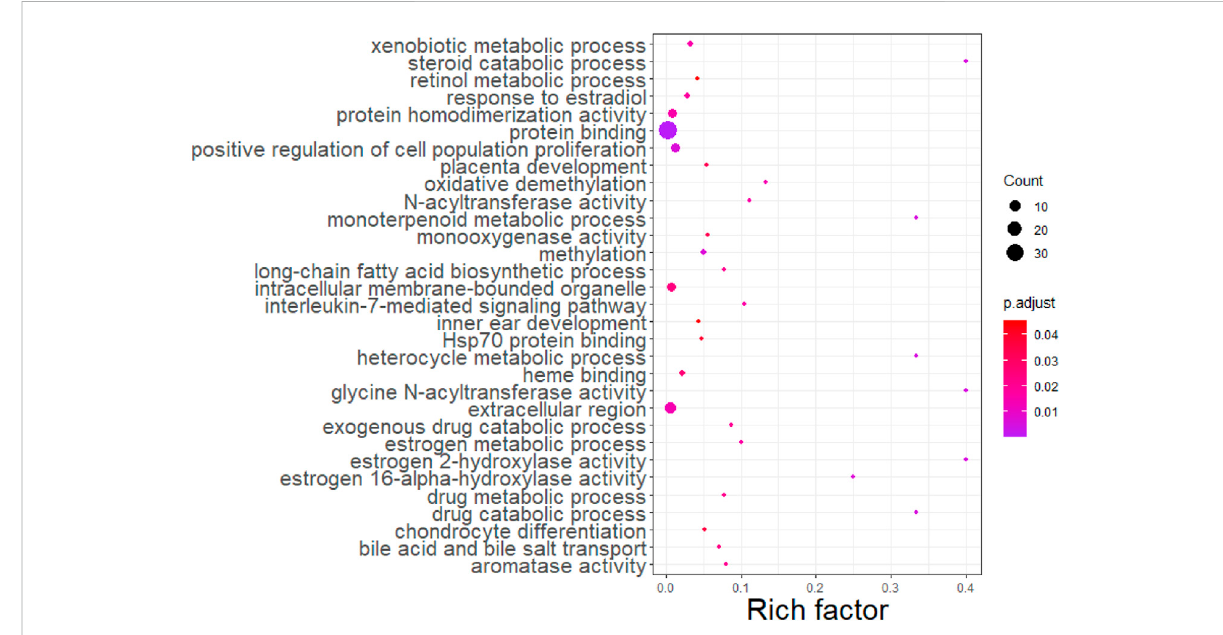
FIGURE 4 GO enrichment analysis for 56 genes